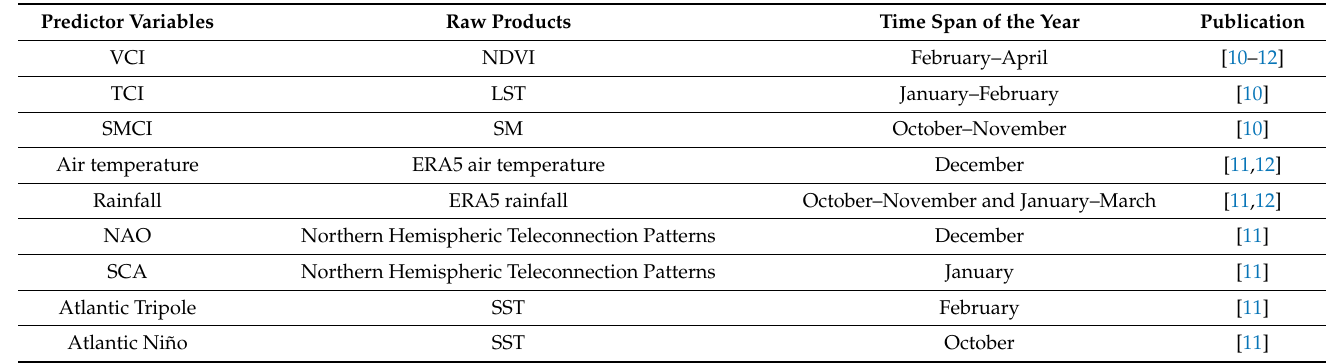
Table 2. Input predictors for the forecasting model and time span of the year when these variables are considered based on previously highlighted biophysically sound